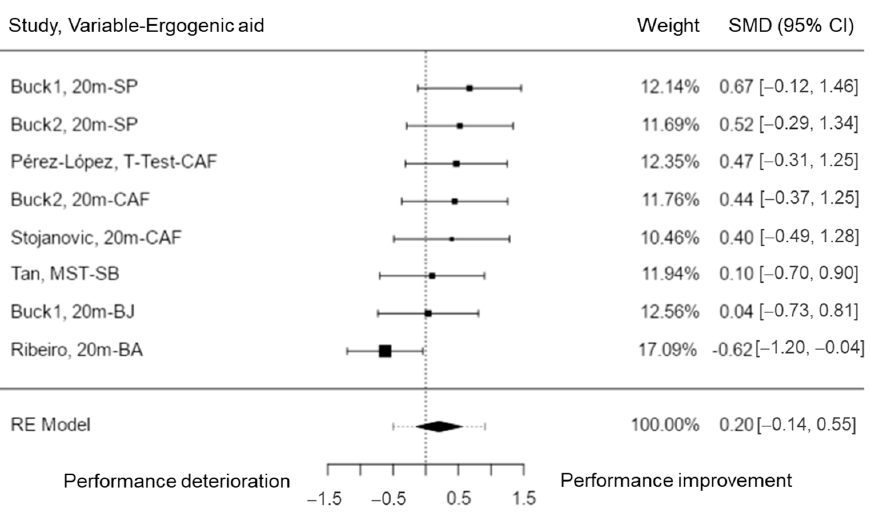
Figure 5. Sprint performance forest plot. 20m = 20 m sprint; MST = mean sprint time; T-Test = T Agility